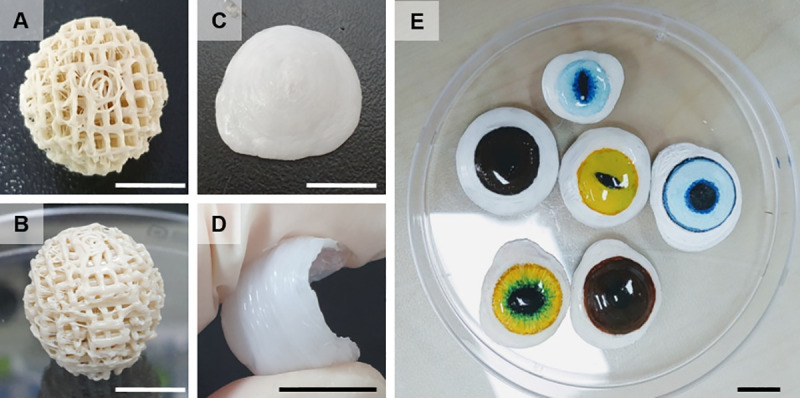
Three-dimensional printout of the orbital implant.Sky view (A) and side view (B); ocular prosthesis, sky view (C) and flexible side view (D). The prosthesis was painted with an acrylic color similar to the intact eye. After drying, it was coated with a biocompatible light-curing varnish (E). Bar = 1cm.